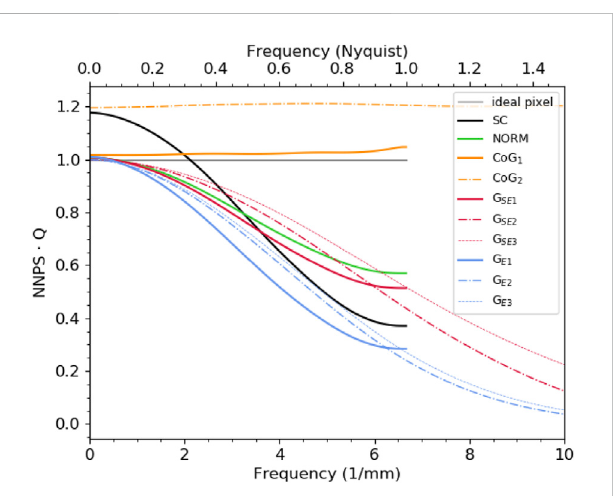
FIGURE 7 MTF for the different probed processing methods. The frequency range is expressed both in absolute values and as a fraction of the physical Nyquist limit.